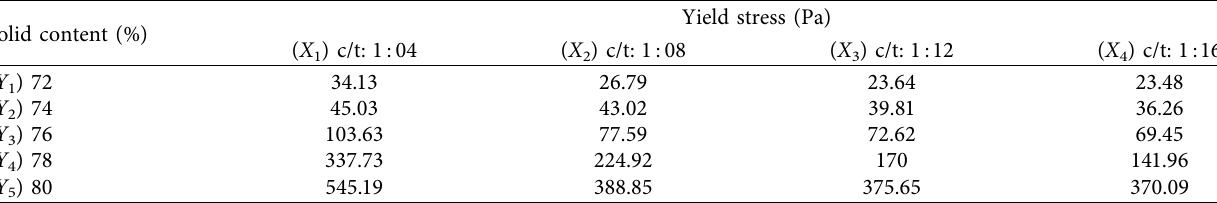
Figure 2: Relationship between apparent viscosity and shear rate with different c/t ratio and SD: (a) c/t ratio of 1: 08; (b) SD of Table 5: ANOVA data of CUTB samples.